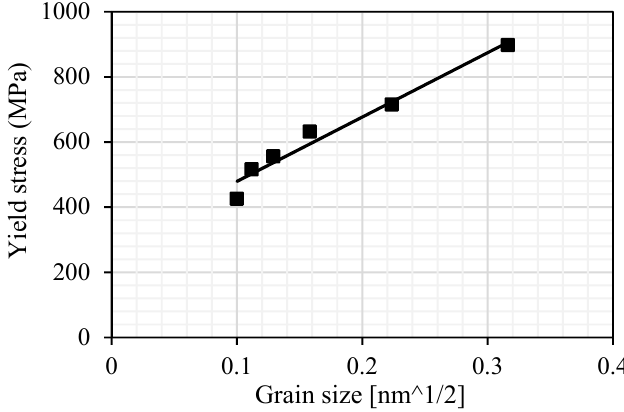
Figure 17. The numerical results of NC copper presenting the crystallite size dependency on the yield strength.